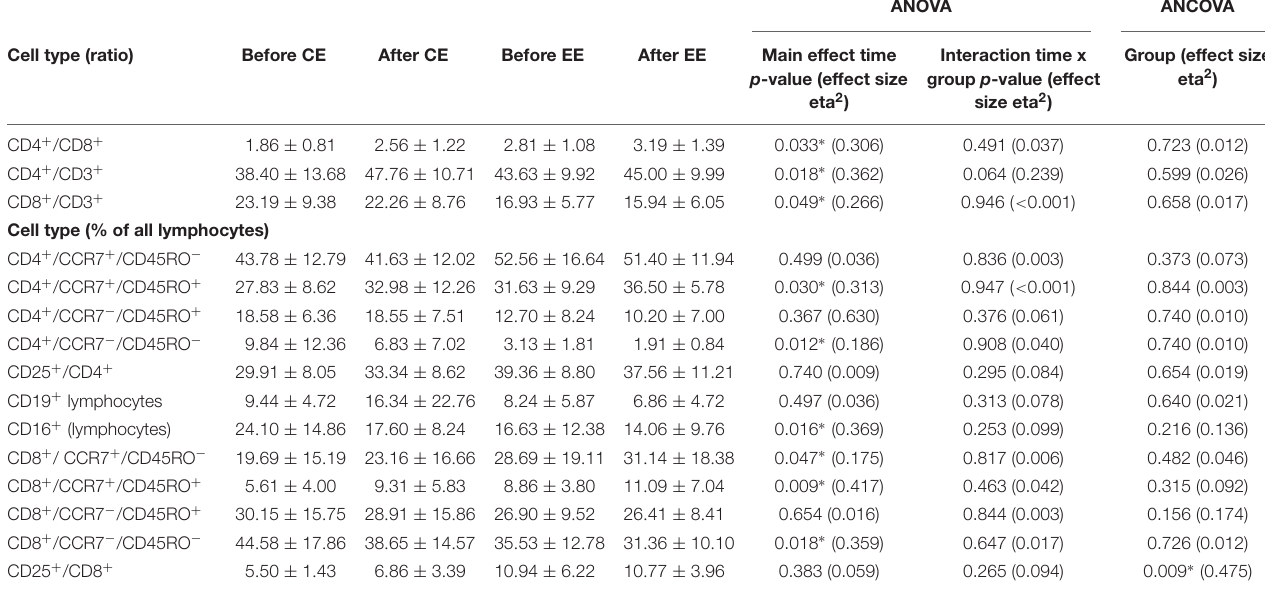
TABLE 1 | Proportional change of T-cell subpopulations before and after CE